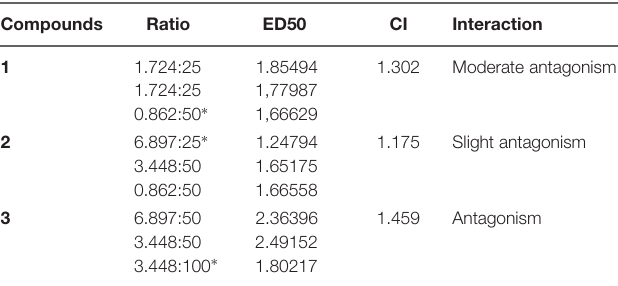
TABLE 7 | Types of interaction between dimeric naphthoquinone derivatives and doxorubicin in MDR mouse T-cell lymphoma cell line. Compounds Ratio ED50 CI